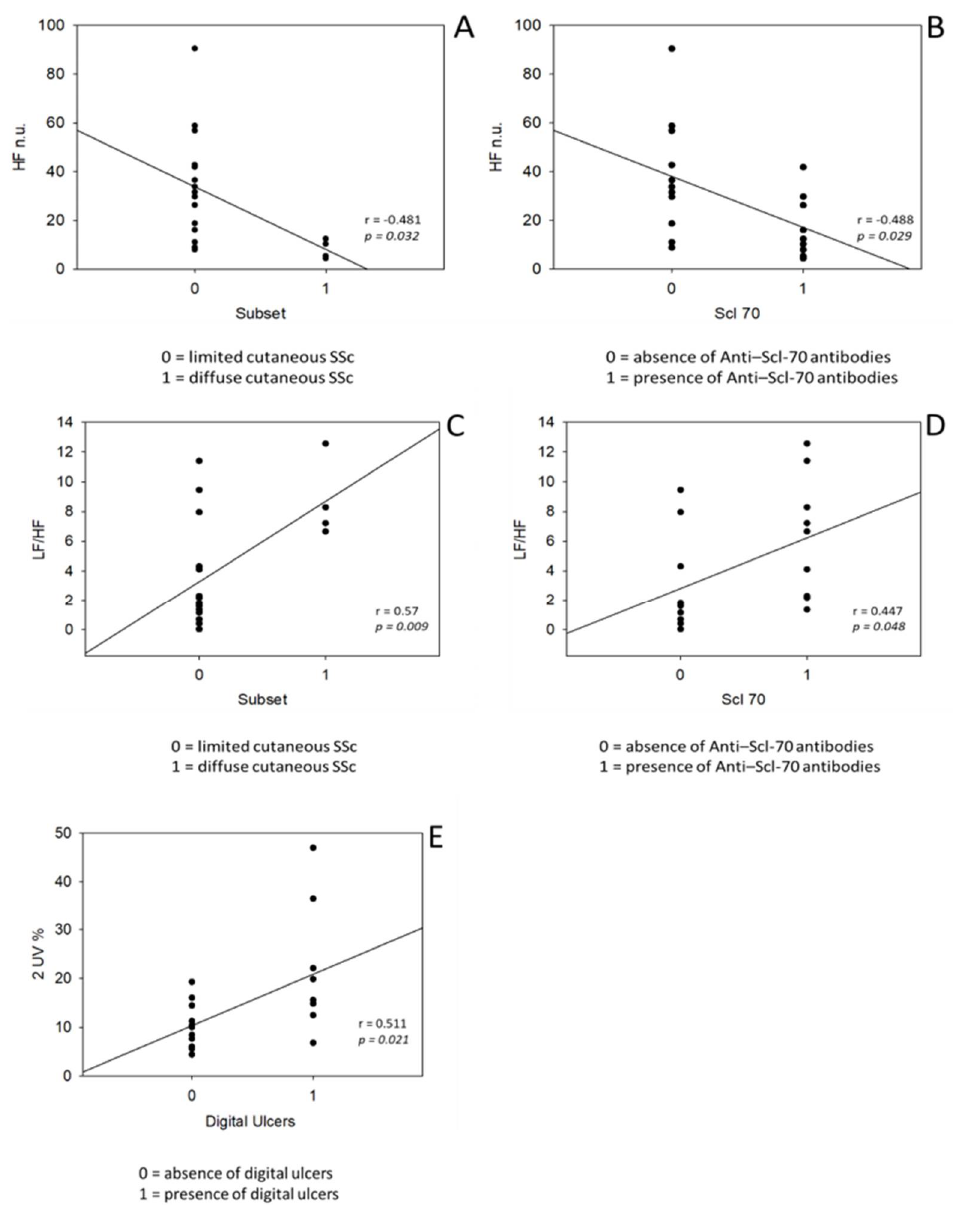
Figure 2. Correlation between cardiovascular parameters and SSc clinical features. Abbreviations: HF, high-frequency band; LF, low-frequency band; n.u., normalized units; SSc, systemic sclerosis; Scl-70, Anti-topoisomerase I antibodies; 2UV%, patterns with 2 unlike variations. Significant p values < 0.05.